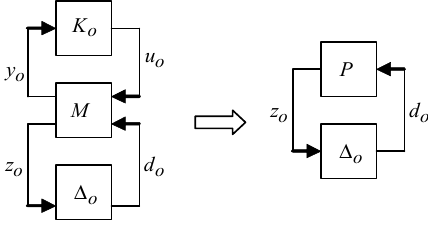
Fig. 1. M − ∆ o − K o and P − ∆ o block diagrams.